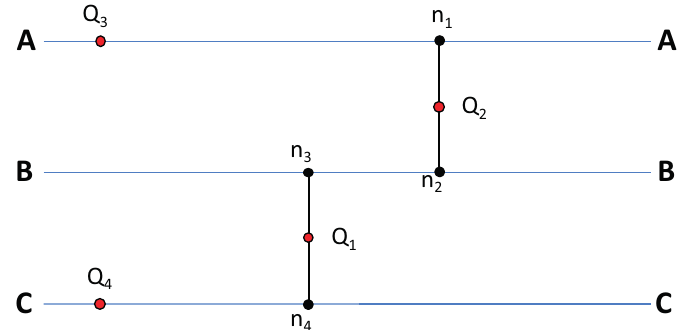
Figure A1. The scheme of quantum router: simplified diagram of the